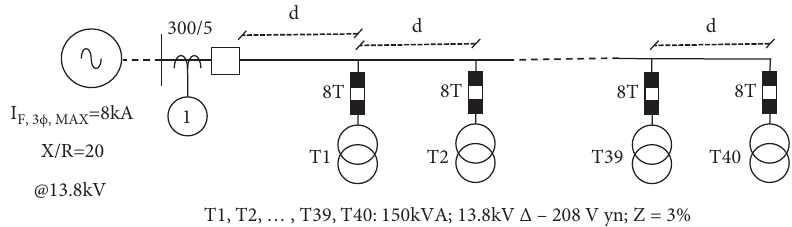
Figure 7: One-line diagram of the illustrative example about application of developed